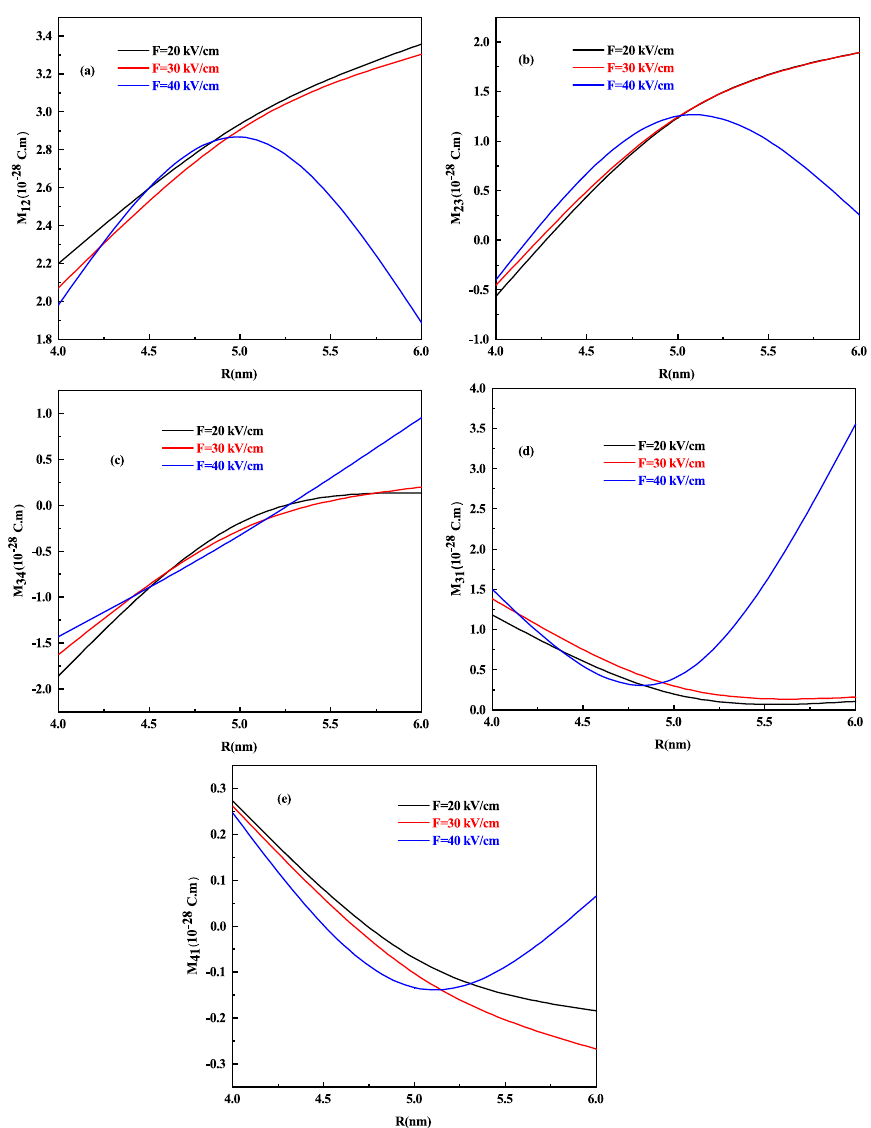
Figure 5. The DM elements ( a ) M 12 , ( b ) M 23 , ( c ) M 34 , ( d ) M 31 , and ( e ) M 41 as a function of pro- late QD Radius R for h=7 nm and for different values of the lateral electric field F = 20,30 and 40 kV/cm